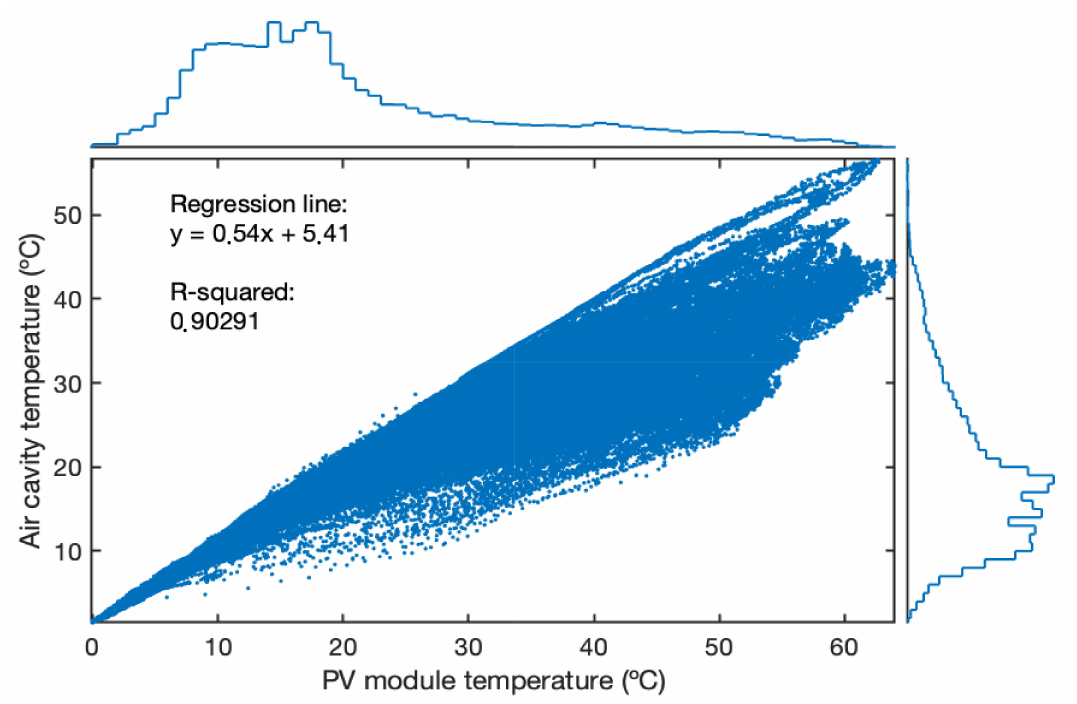
Figure 9. Relationship between air cavity and PV module temperature for the entire register period, with the histogram of the temperature bins of 1 ◦ C each